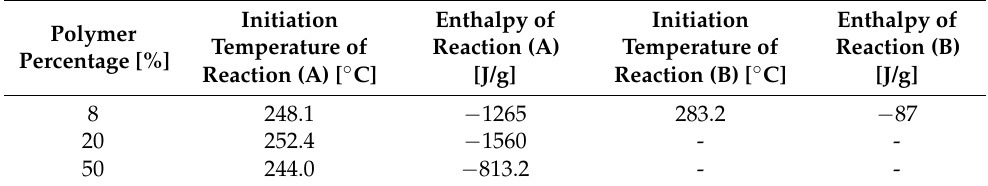
Table 2. Results of DSC analysis of AN and PVC-P mixture with different proportions.